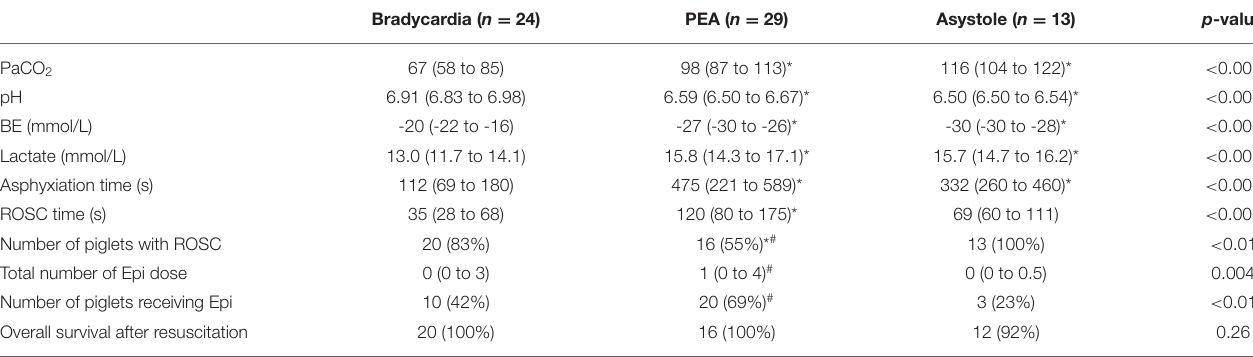
TABLE 2 | Characteristics of asphyxia, resuscitation, and survival of asphyxiated